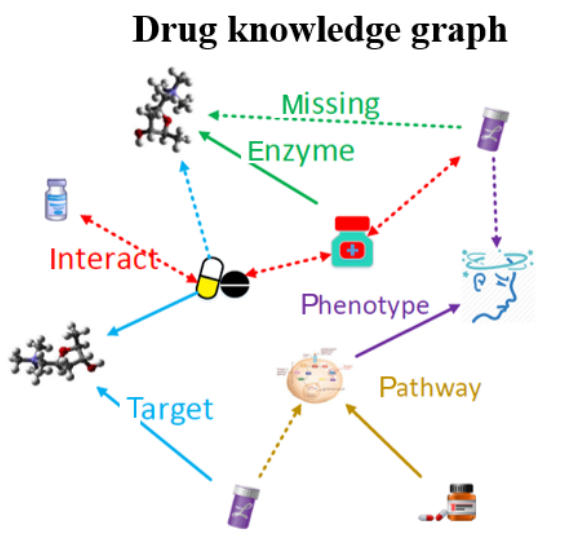
Figure 2. A drug knowledge graph is shown on the left with missing relations represented as dotted lines. There is usually no direct DDI relation between drugs. DDI descriptions from the biomedical text are shown on the right. The words in red represent concerns regarding DDI information in terms of both adverse DDIs and in-depth ways drugs can interact in pharmacology. DDI: drug-drug